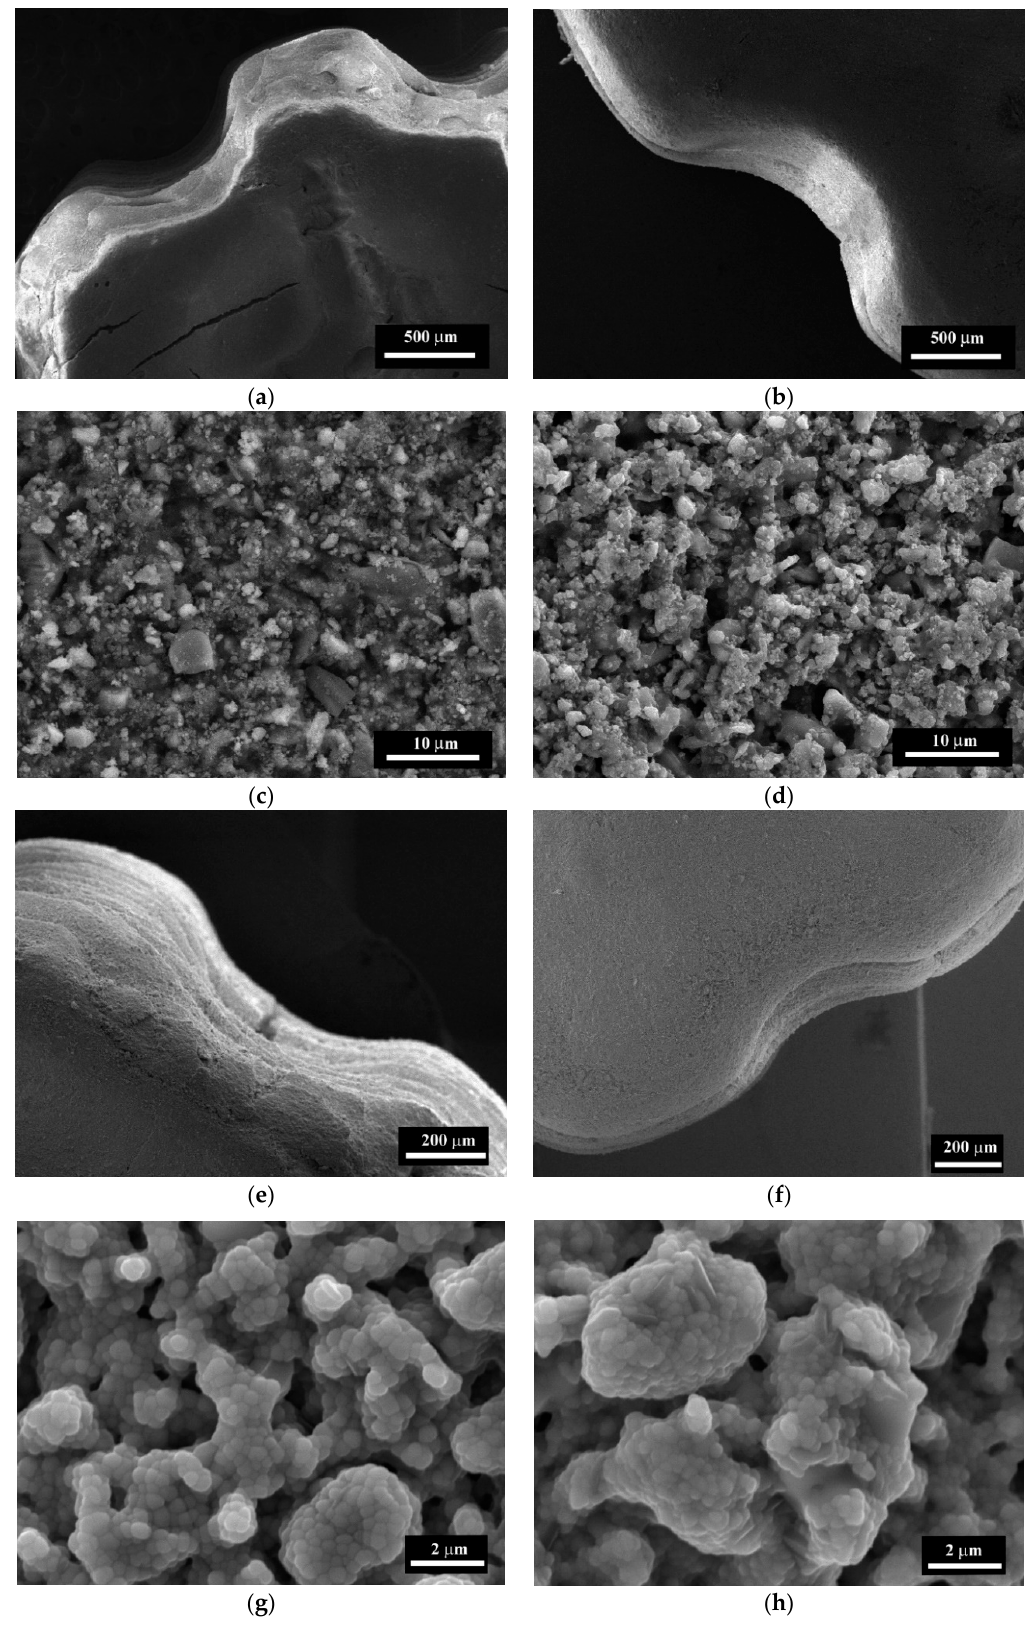
Figure 14. SEM images of composition I ( a , c , e , g ) and composition II ( b , d , f , h ) after printing (a , b , c , d ) and sintering at 1450 °C ( e , f , g , h ).